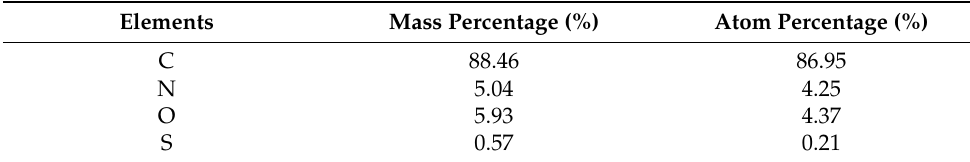
Figure 2. TEM image ( A ) and particle size distribution ( B ) of the synthesized N-CDs. Table 1. Element species and content analysis.